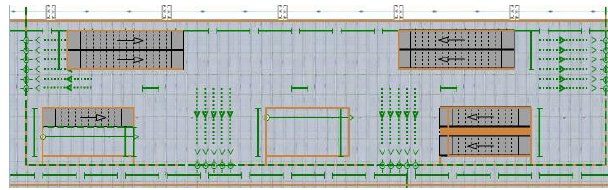
Figure 5. Environment model establishment of subway station.